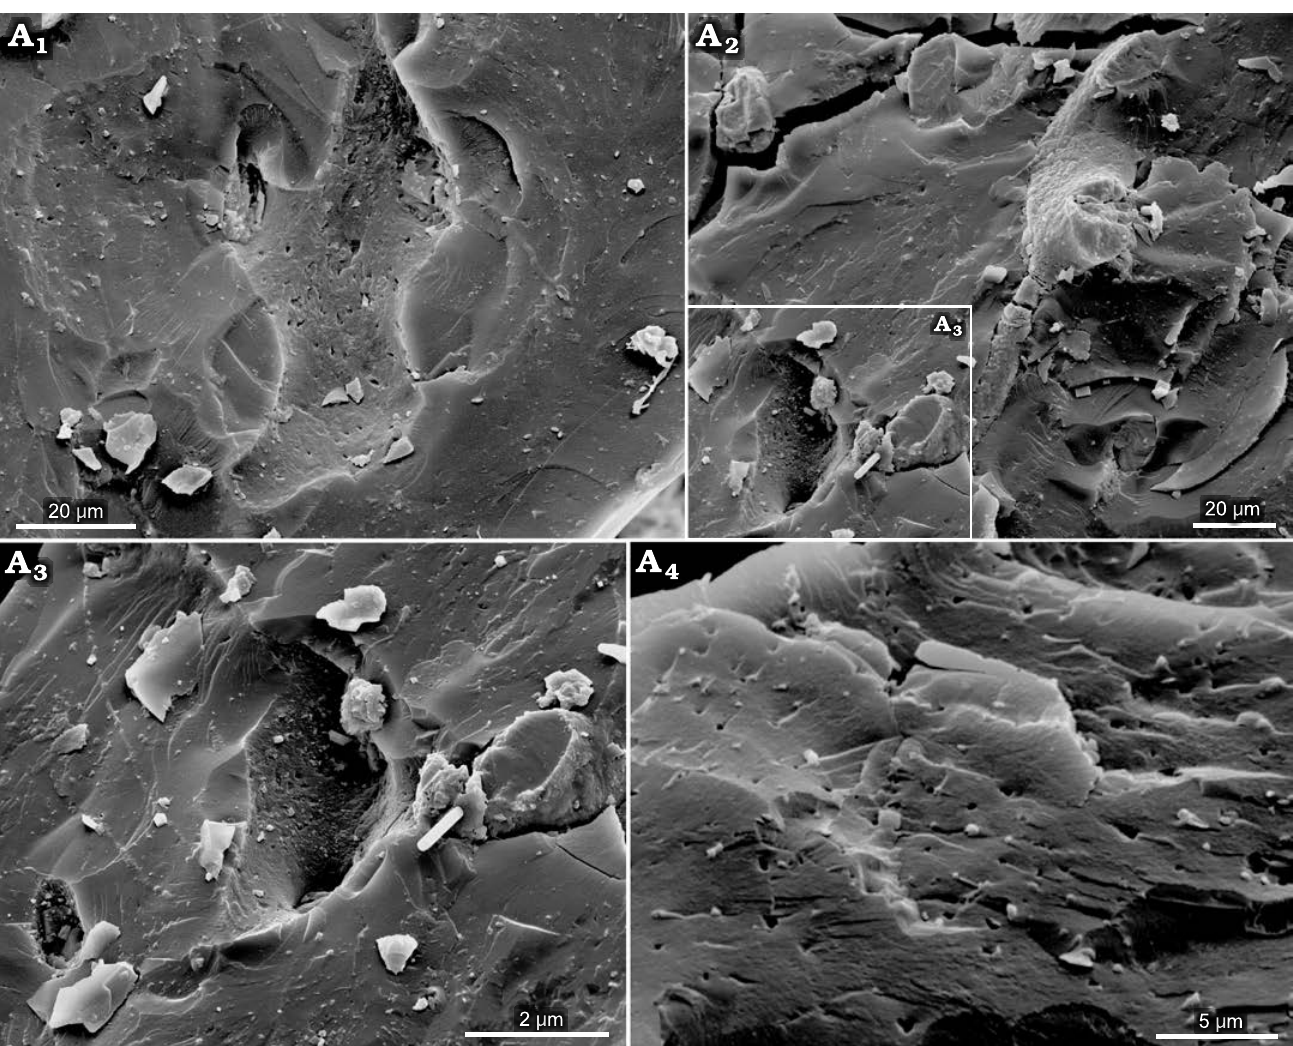
Fig. 11. The ultrastructure of the hypothesized “beak” of the coleoid cephalopod Phragmoteuthis bisinuata (Bronn, 1859) (GBW 2006/011/0009); lower Carnian, Upper Triassic, Cave del Predil, NE Italy. A 1 , an imprint of a bone-like nanostructure showing “nano-porosity” and three rounded openings left by missing processes (enlarged detail of Fig. 10A 1 ); A 2 , a semi-ring structure with thin processes ended by swollen rounded part; A 3 , a deep imprint of a swollen bone-like nano-structure which left two openings of the assumed processes (enlarged detail of A 2 marked in the left bottom corner); A 4 , a mangy skin like micro-lamination and micro-porosity of the